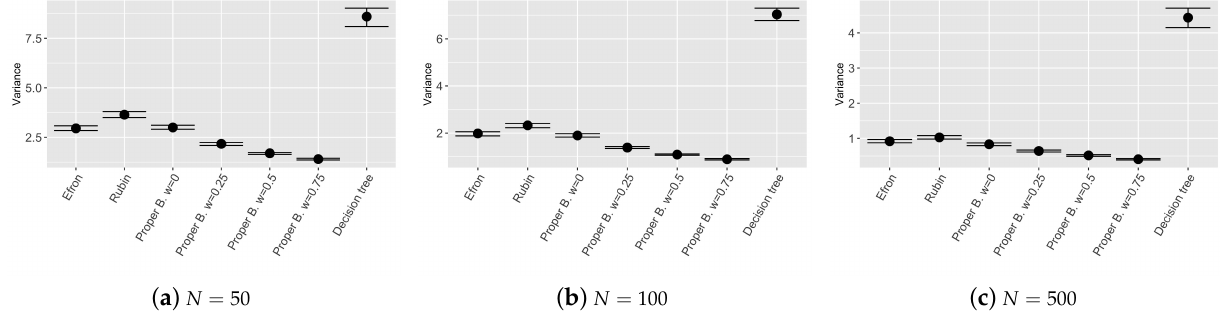
Figure 5. Nonparametric confidence intervals for the variance on the validation set varying N , number of observations in the training